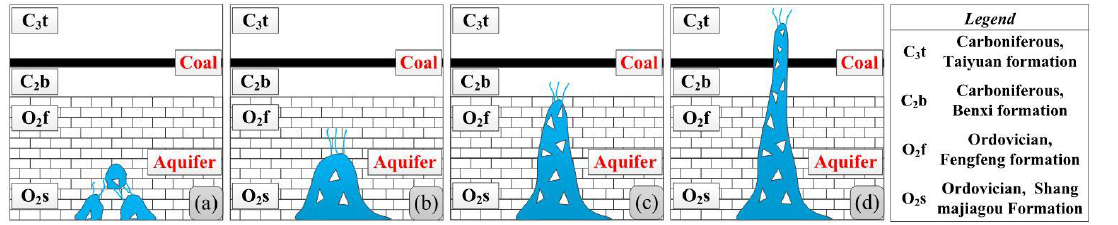
Figure 1. Formation process of KCC. ( a ) Connection of caves; ( b ) initial stage; ( c ) growth stage; ( d ) final stage.